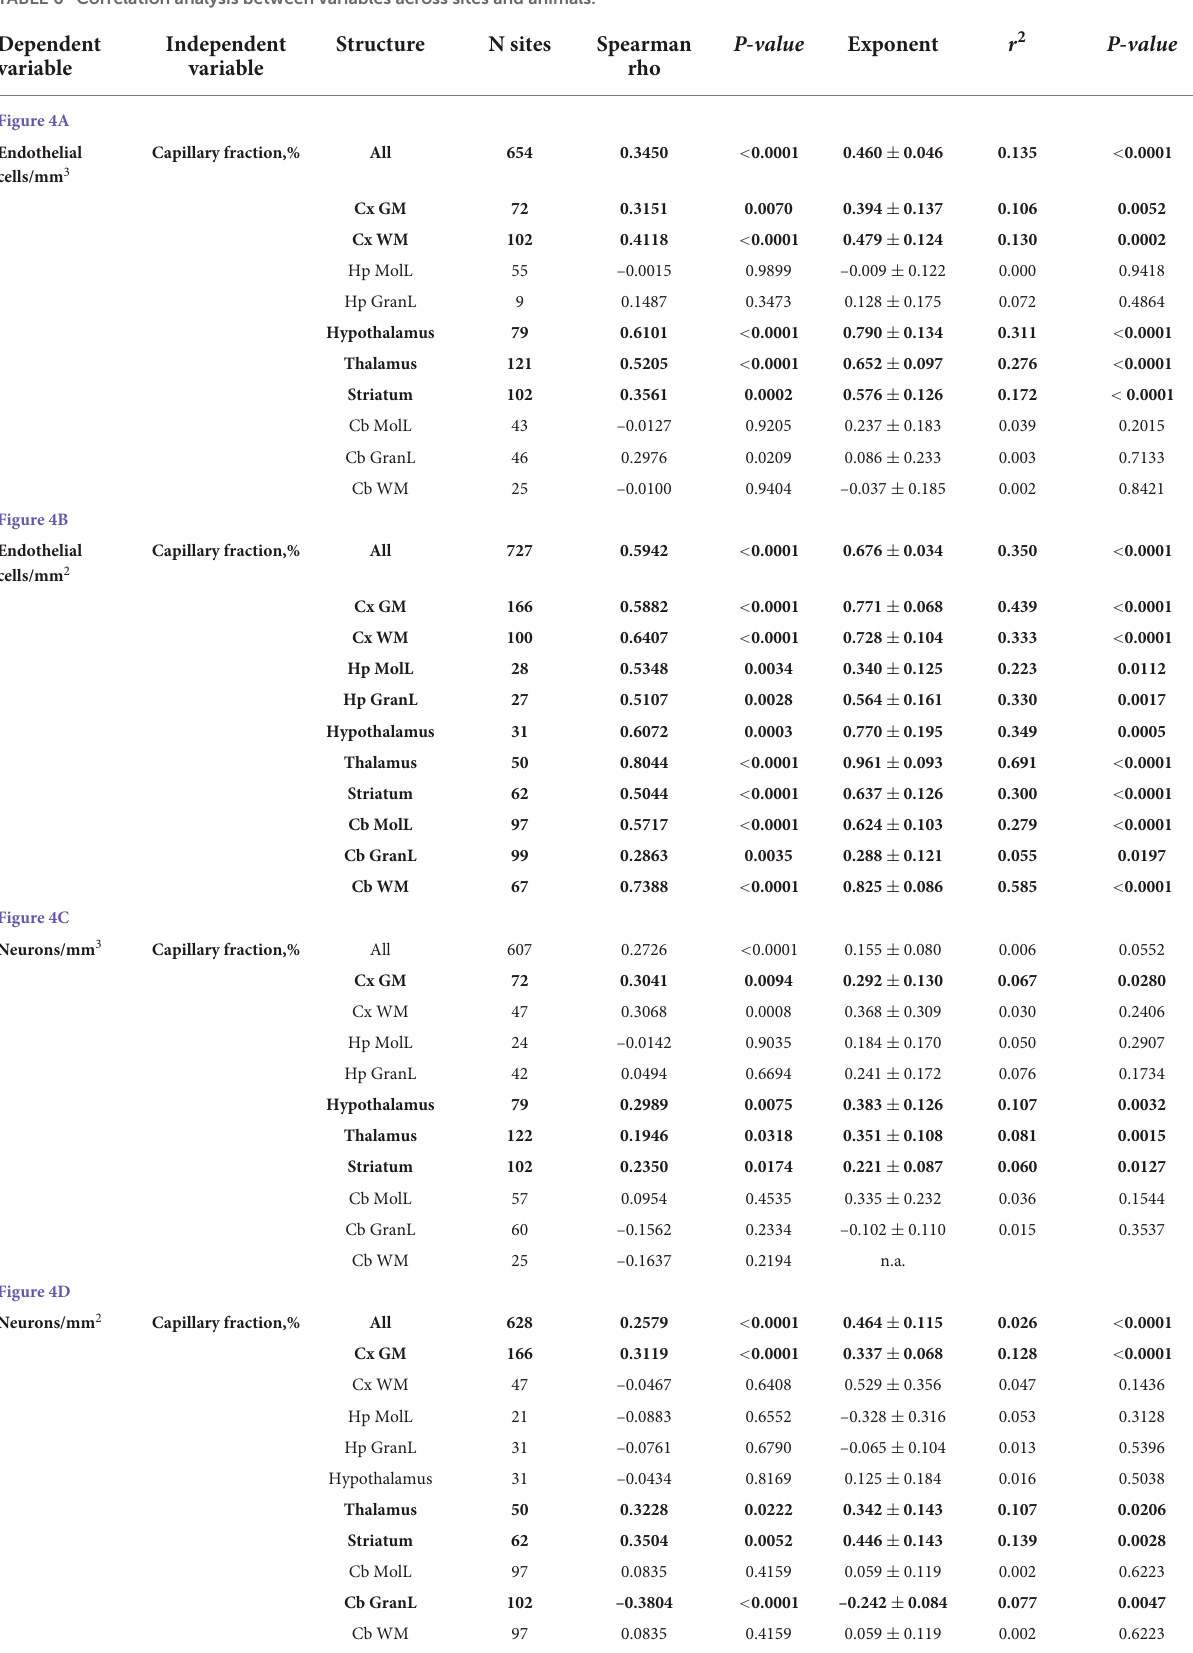
TABLE 6 Correlation analysis between variables across sites and